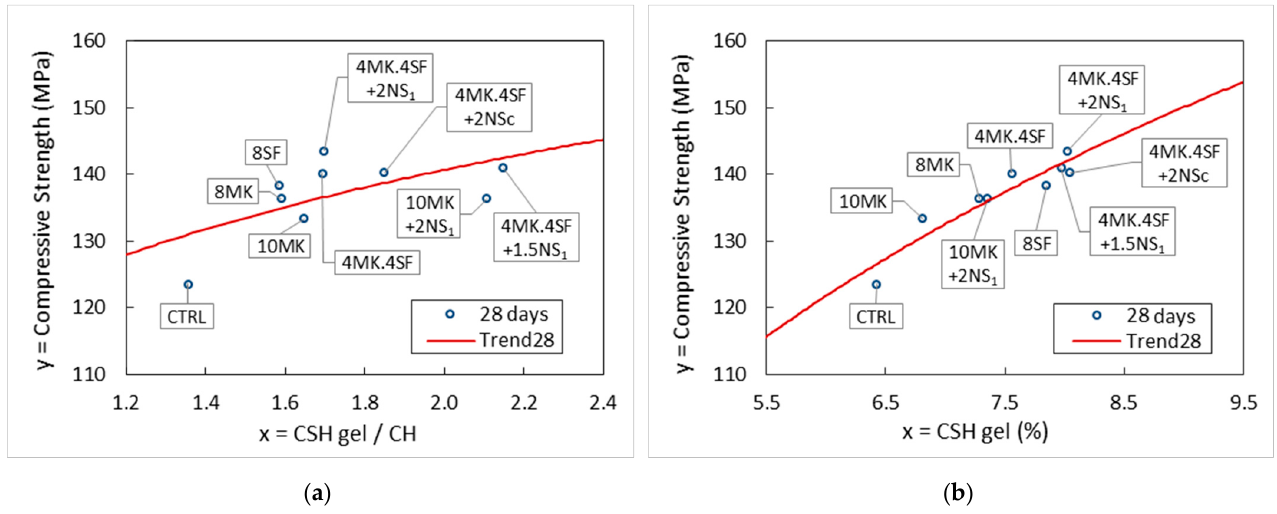
Figure 11. Influence of portlandite ( a ) and CSH gel ( b ) on compressive strength at 28 days.